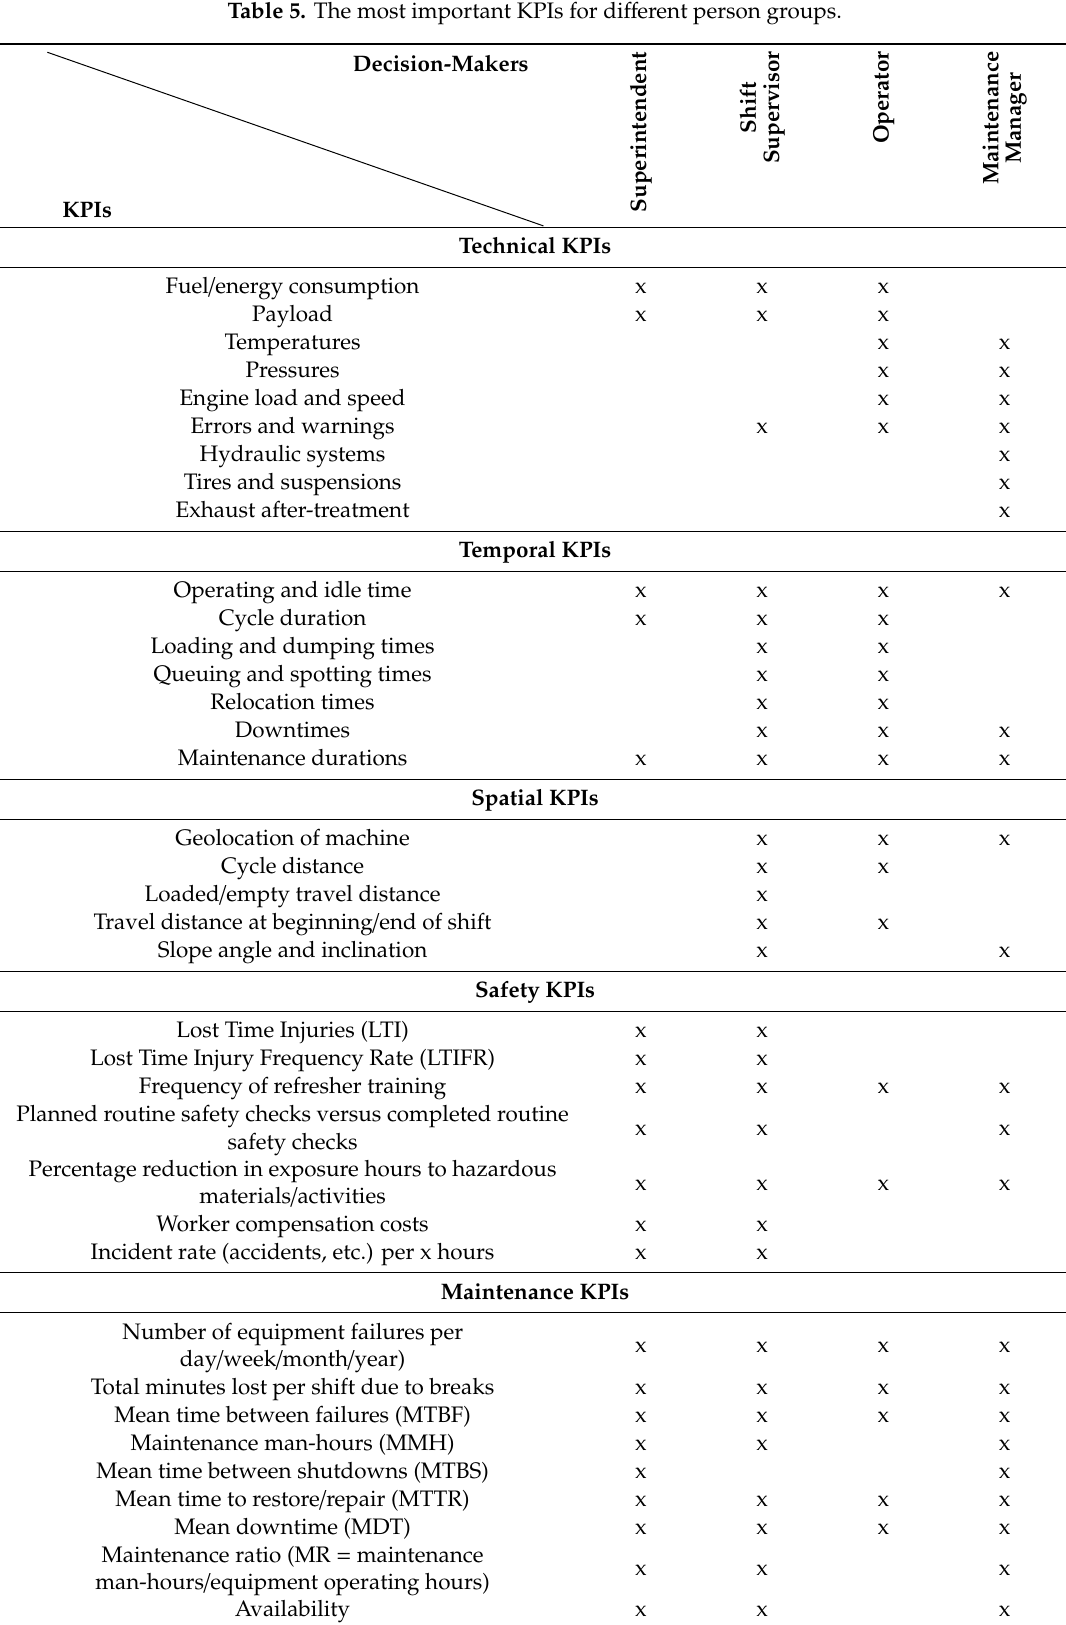
Table 5. The most important KPIs for di ff erent person